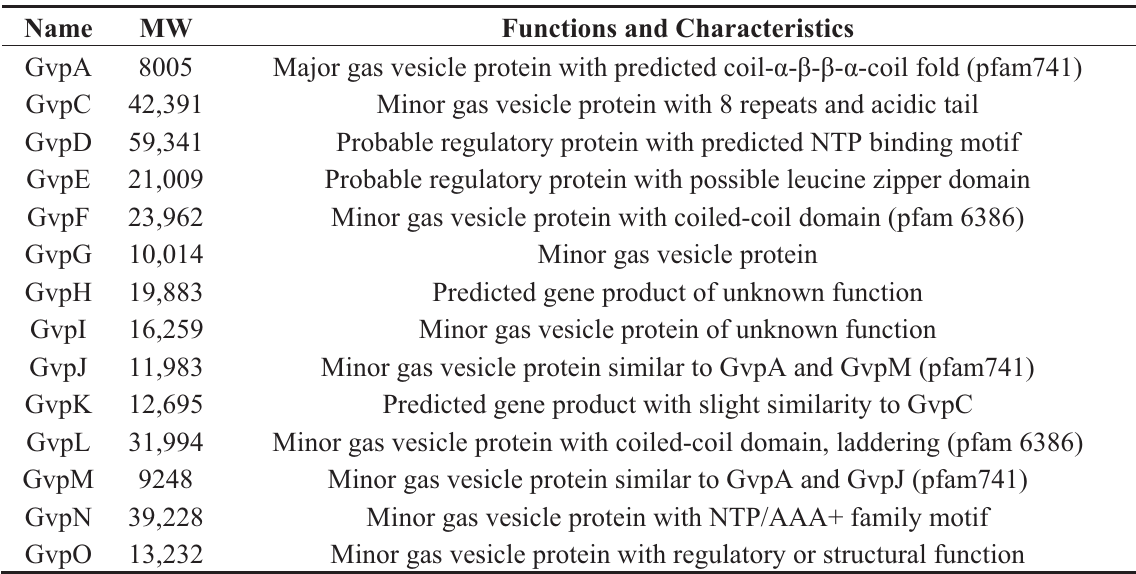
Table 1. Gas vesicle proteins and predicted proteins in Halobacterium sp.